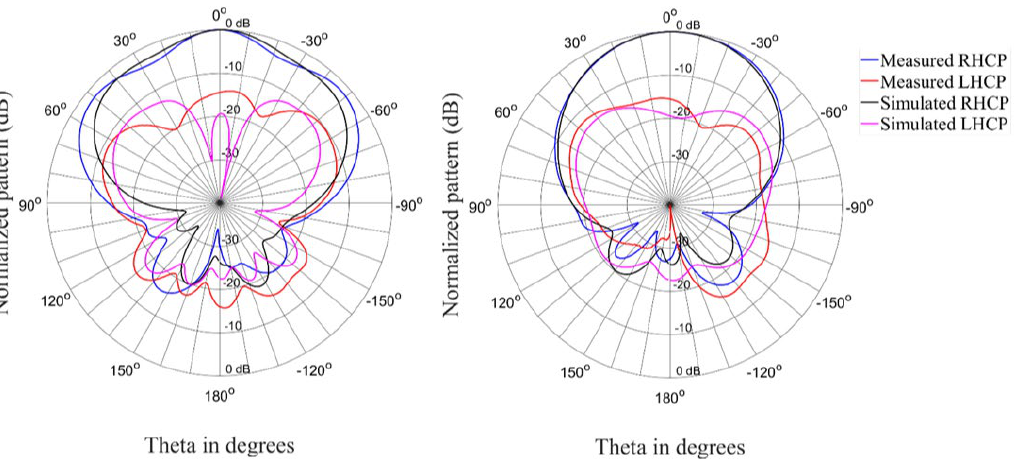
Figure 12. Radiation patterns (Phi = 0° and Phi = 90°) of the antenna in the circular state at 2.35 GHz.